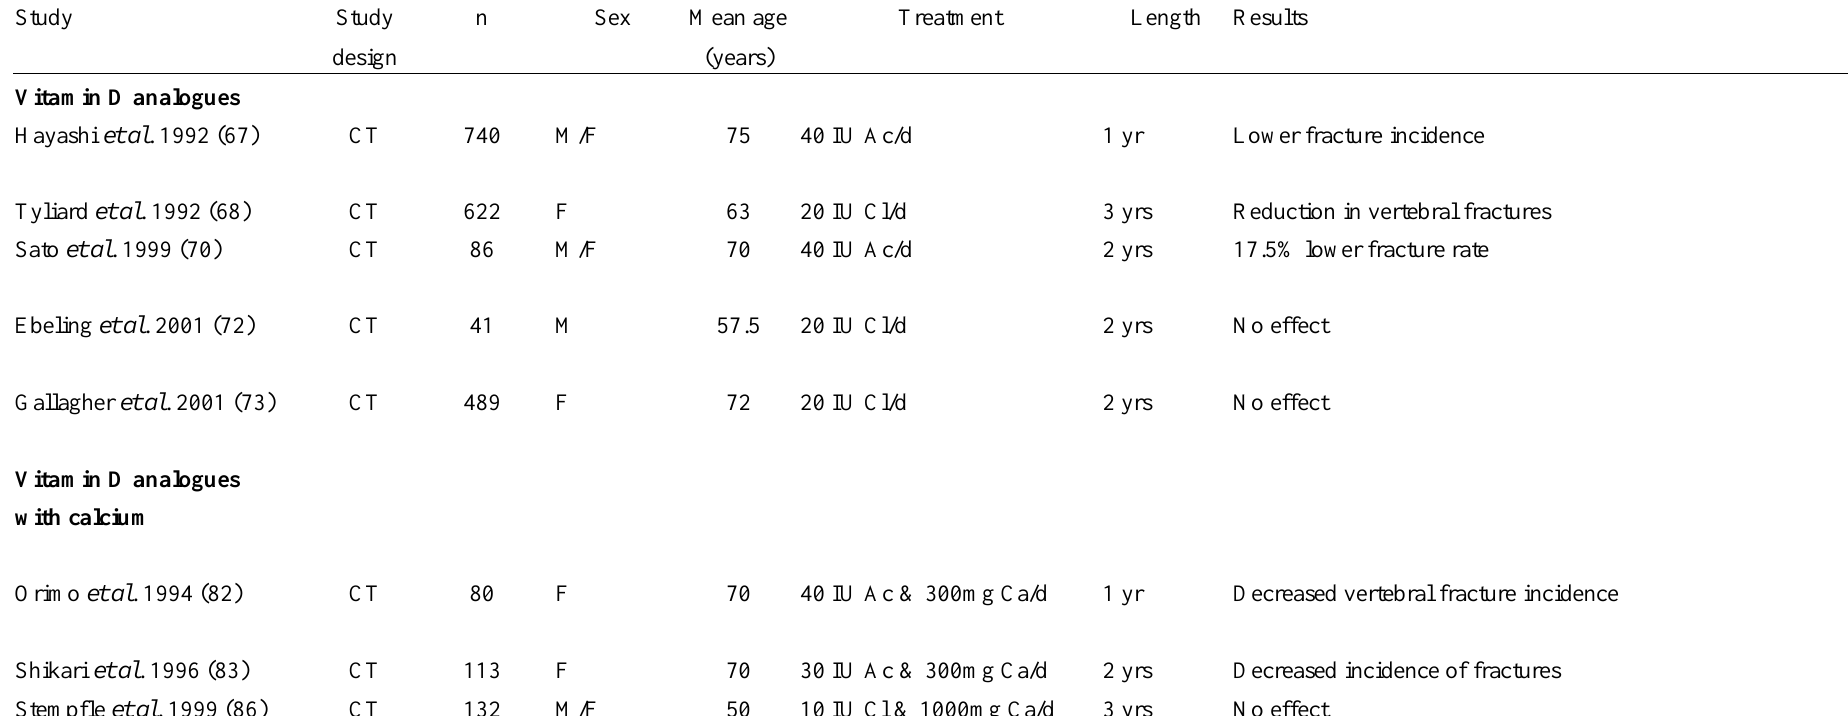
Table 3. Intervention with vitamin D analogues (with / without calcium) on fracture